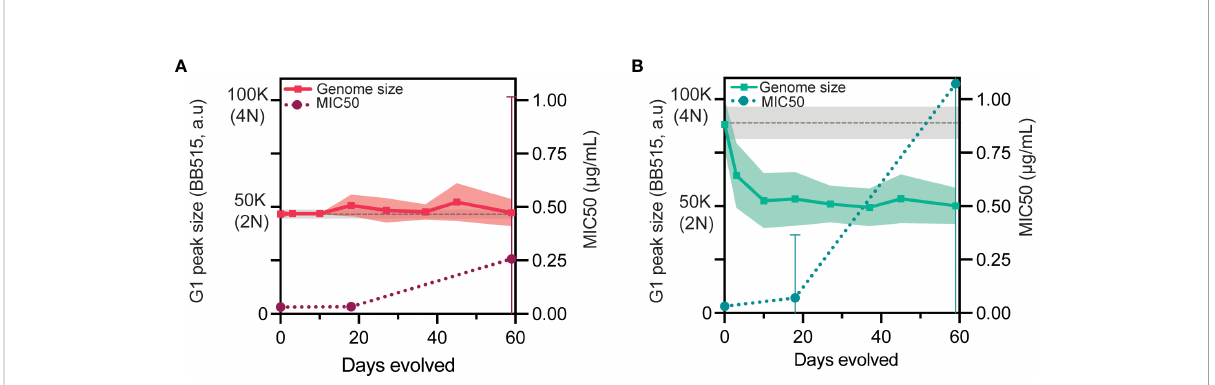
FIGURE 2 Large scale genome size reductions occur prior to adaptation. (A) Diploid genome size measured throughout experimental evolution with the mean (solid line) and +/- 1SD ( fi lled-pink) of G1 peaks plotted in a.u (arbitrary units) on the left y-axis. The gray dashed line indicates the mean of the ancestral diploid controls with +/-1SD ( fi lled-gray, n=72). Average MIC50 (maroon dotted-line) is plotted on the right y-axis with +/-1SD. (B) Tetraploid genome size measured throughout experimental evolution with the mean (solid line) and +/- 1SD ( fi lled-green) of G1 peaks plotted in a.u (arbitrary units) on the left y-axis. The gray dashed line indicates the mean of the ancestral diploid control with +/-1SD ( fi lled-gray, n=64). Average MIC50 (teal dotted-line) is plotted on the right y-axis with